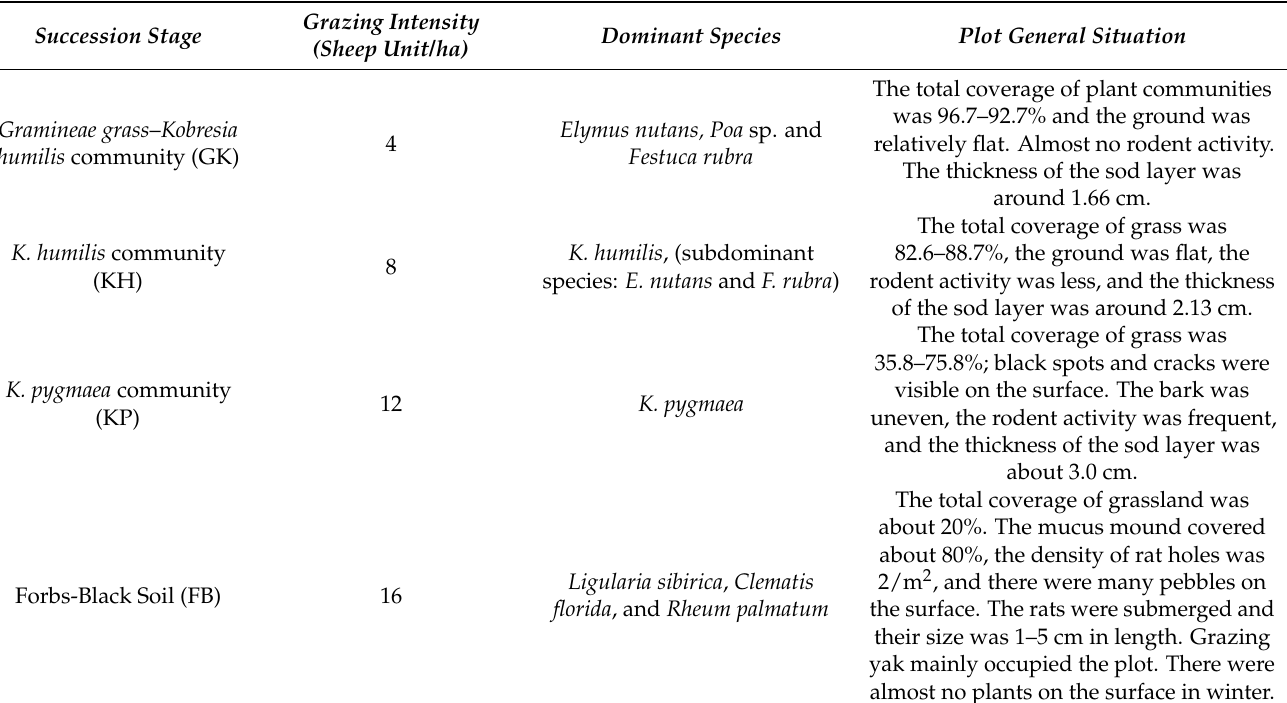
Table 1. Feature of four types of